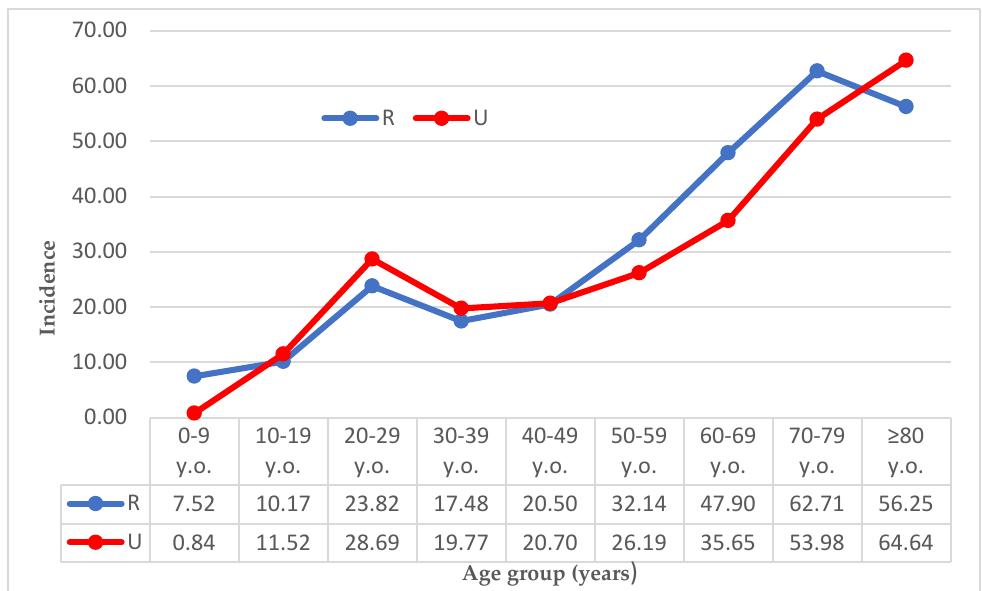
Figure 3. Prevalence (%) of dislocations by age and sex. Legend: FR, female rural population; FU, female urban population; MR, male rural population; MU, male urban population.